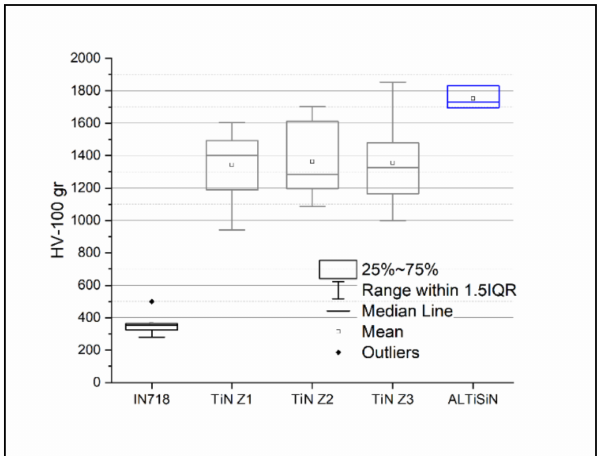
Figure 9. Vickers hardness for different evaluated